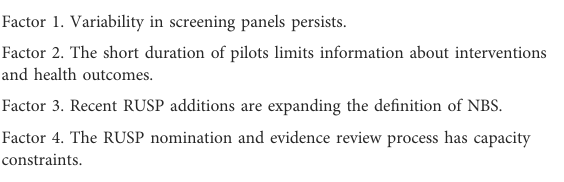
TABLE 1 Four challenges in newborn screening pilot*. Factor 1. Variability in screening panels persists. Factor 2. The short duration of pilots limits information about interventions and health outcomes. Factor 3. Recent RUSP additions are expanding the de fi nition of NBS. Factor 4. The RUSP nomination and evidence review process has capacity